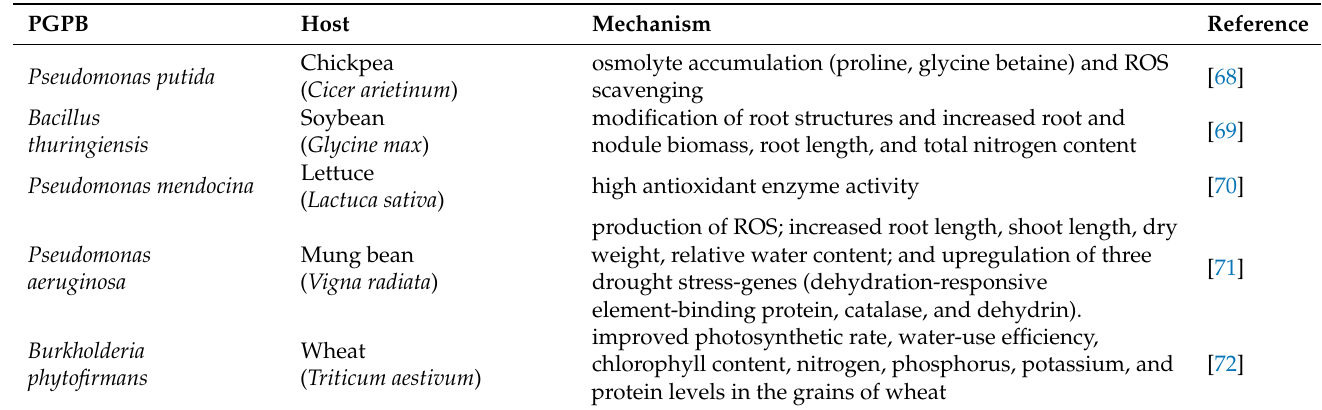
Table 1. Examples of PGPB strains and their mechanisms that alleviate drought stress in different plant